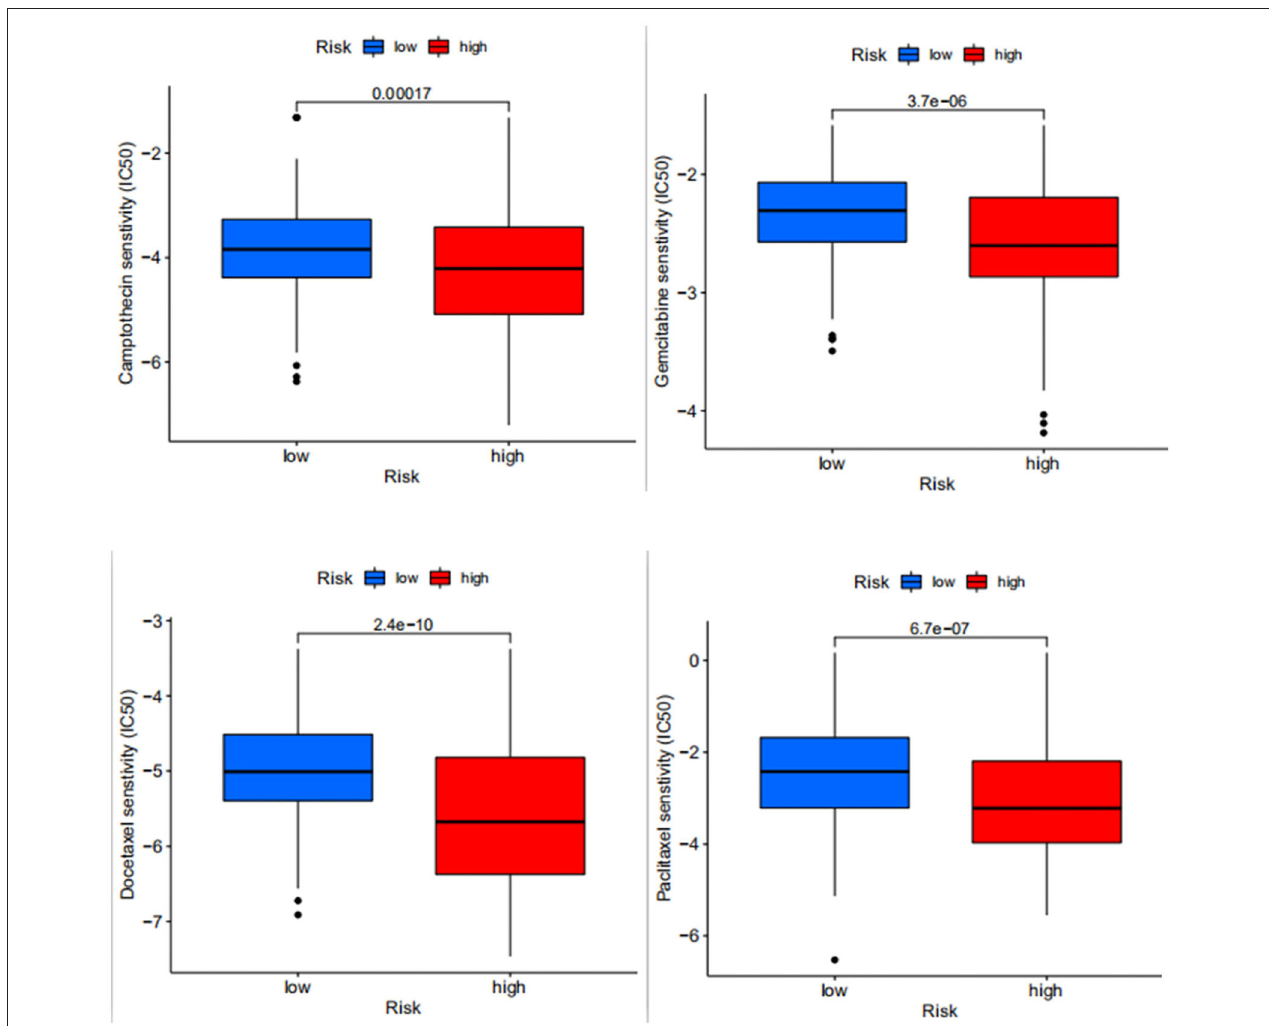
FIGURE 7 | Differences in drug sensitivity between docetaxel, gemcitabine, paclitaxel and camptothecin in high- and low-risk patients, where the higher the IC50 value of the drug, the lower the